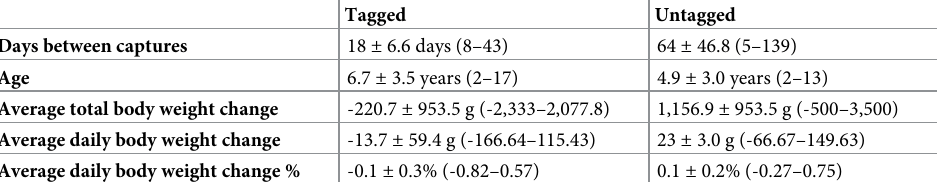
Table 1. Overview of the two Eurasian beaver ( Castor fiber) groups (tagged and untagged) in relation to number of days between captures, and total and daily body weight change between the captures in southeastern Norway 2006–2020. Each variable is presented as the mean with standard deviation and the total range within the